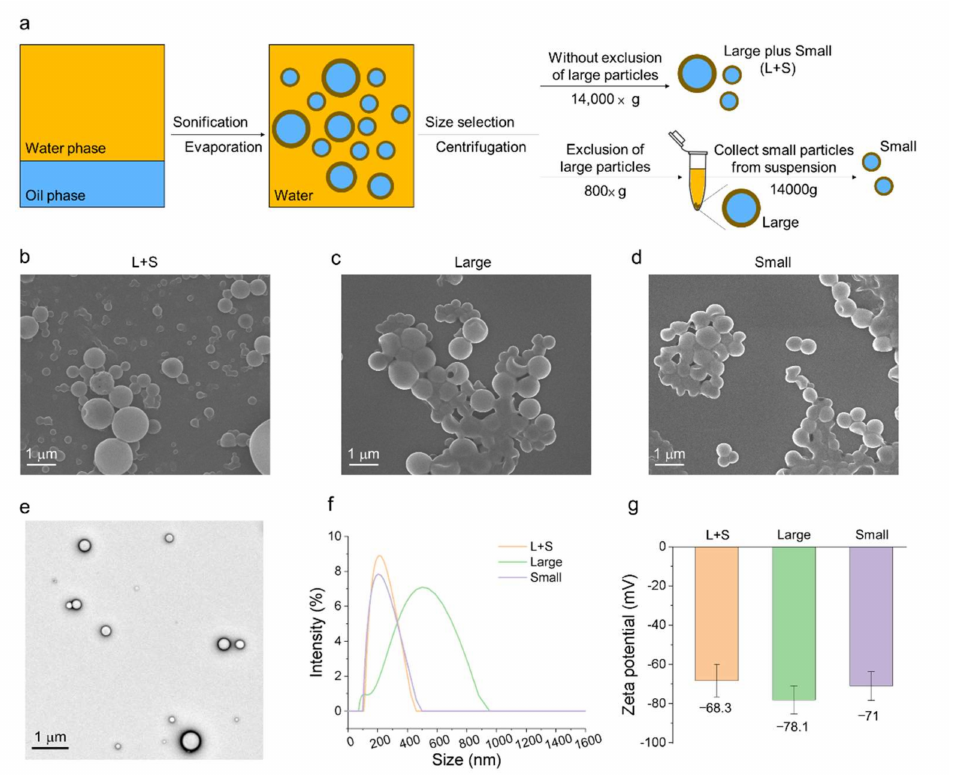
Figure 2. Illustration of the size selection strategy and the characterization of FuNPs. ( a ) Schematic illustration of size selection for FuNP using centrifugation. SEM images of L+S ( b ), Large ( c ), and Small ( d ) FuNPs groups; ( e ) TEM image of the Small FuNPs group; The size ( f ) and zeta potential ( g ) of the different groups were measured using